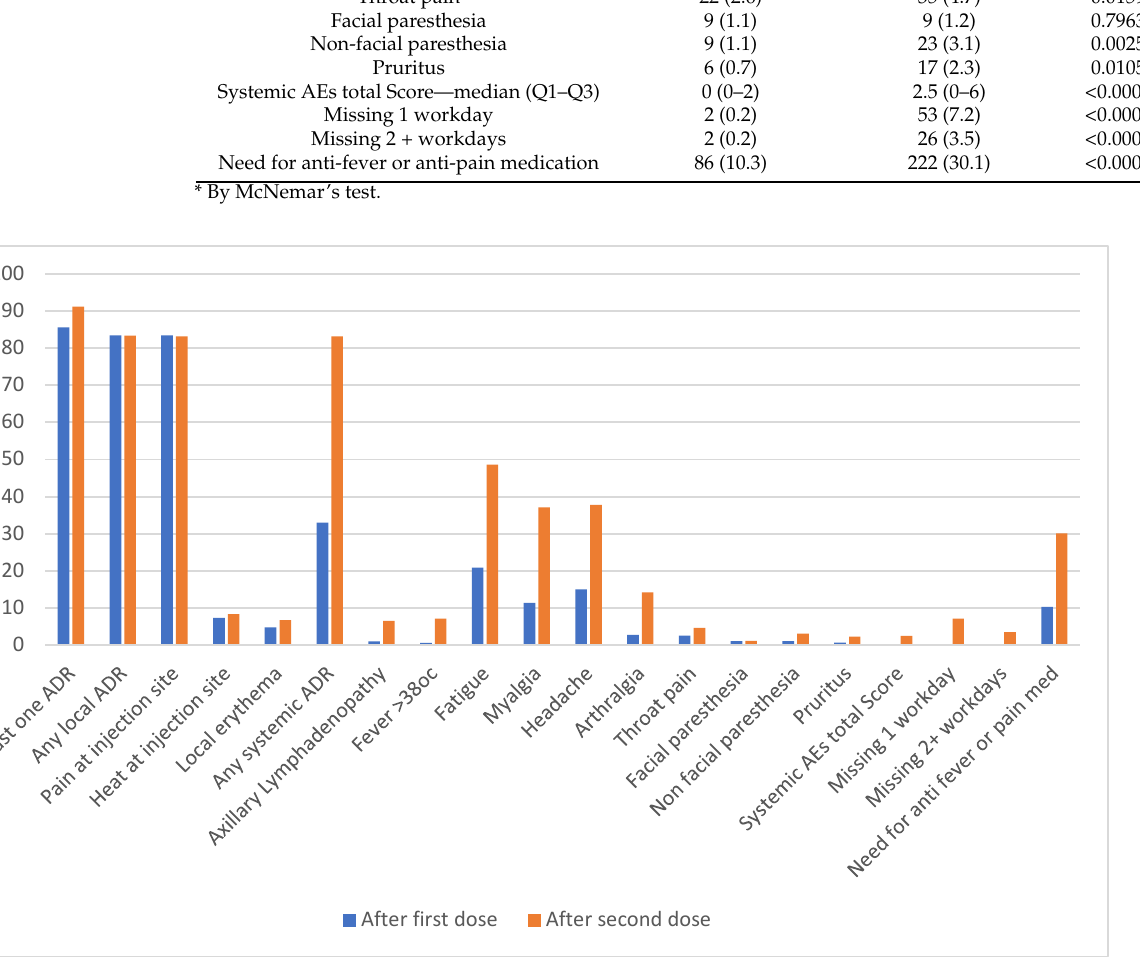
Anti-RBD IgG titer increased significantly from a GMT of 0.11 S/CO (95% CI: 0.08–0.14) 11.7 ± 3.6 days after the first dose to a GMT of 32.55 S/CO (95% CI: 31.11–34.05) 13.7 ± 5.6 days after the second vaccination (Table 3). Anti-RBD IgG GMT after the second dose was significantly higher among females versus males: GMT of 33.5 S/CO (95% CI: 33.85–37.2) vs. 26.9 S/CO (95% CI: 24.1–30.1) ( p < 0.0001). IgG anti-RBD GMT after the second dose was significantly higher among HCWs younger than 55 years versus older HCWs: 35.62 S/CO (95% CI: 34.1–37.2) vs. 26.62 S/CO (95% CI: 23.44–30.2) ( p <